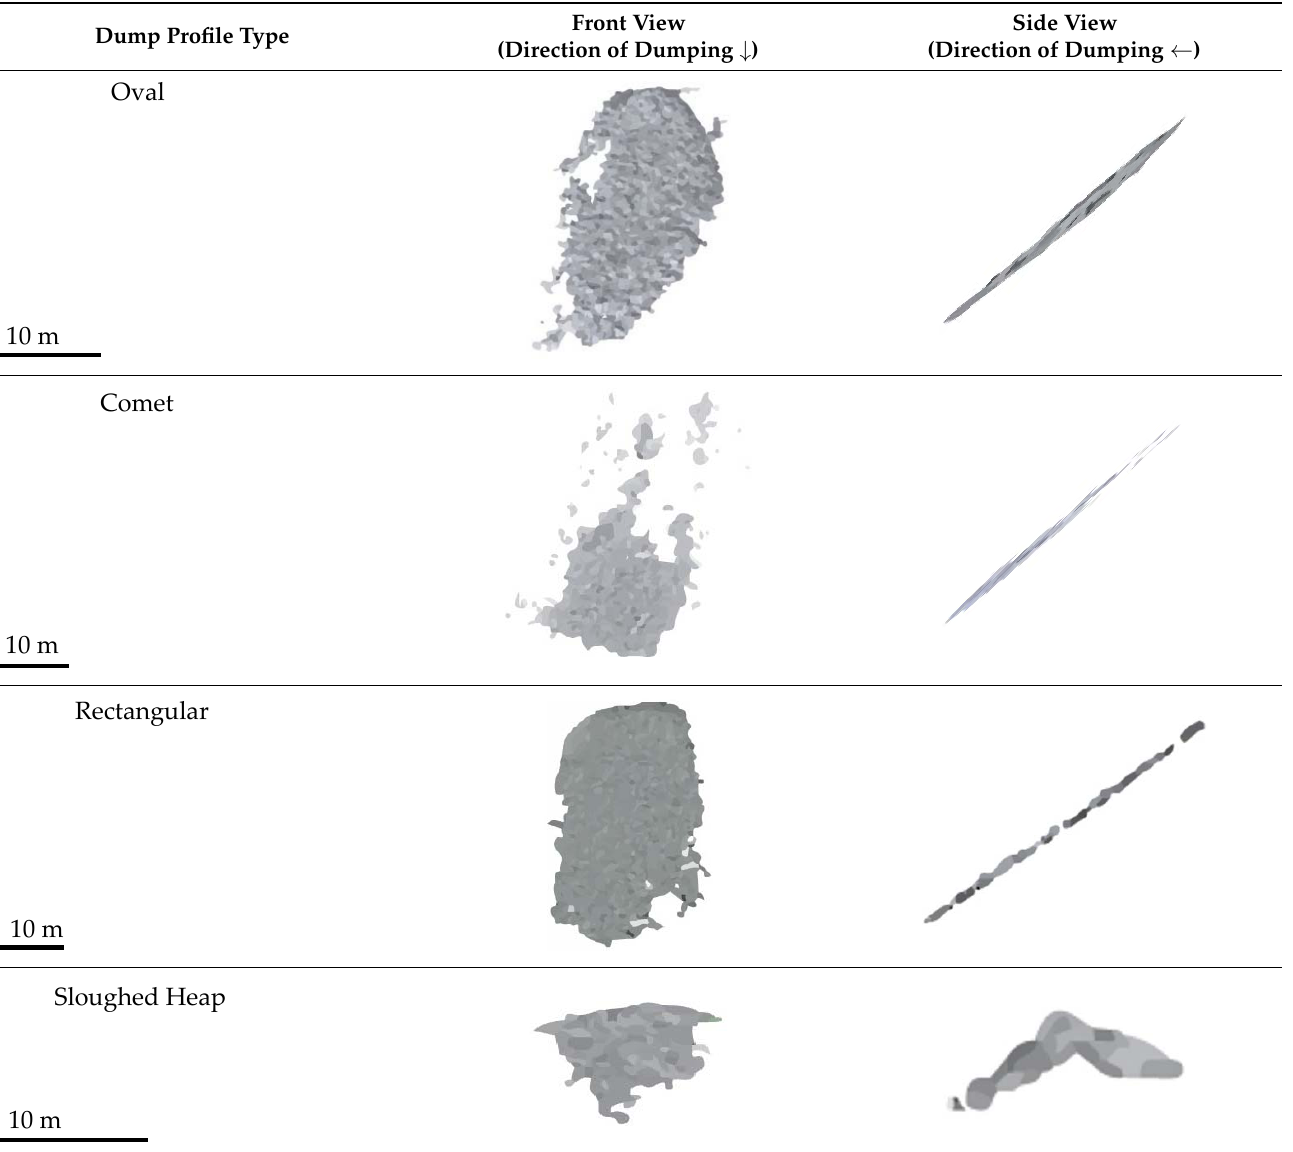
Table 4. Example front and side views of grayscale renderings of the HFM solids created in PointStudio for each of the four dump profile types.